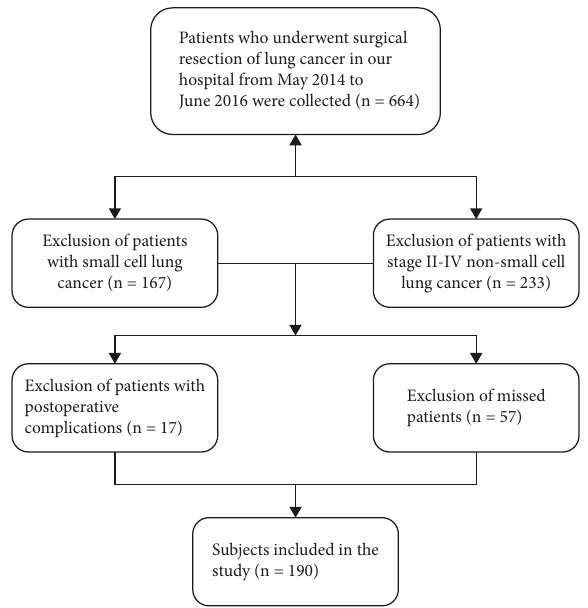
Figure 1: Study flow diagram of the patient